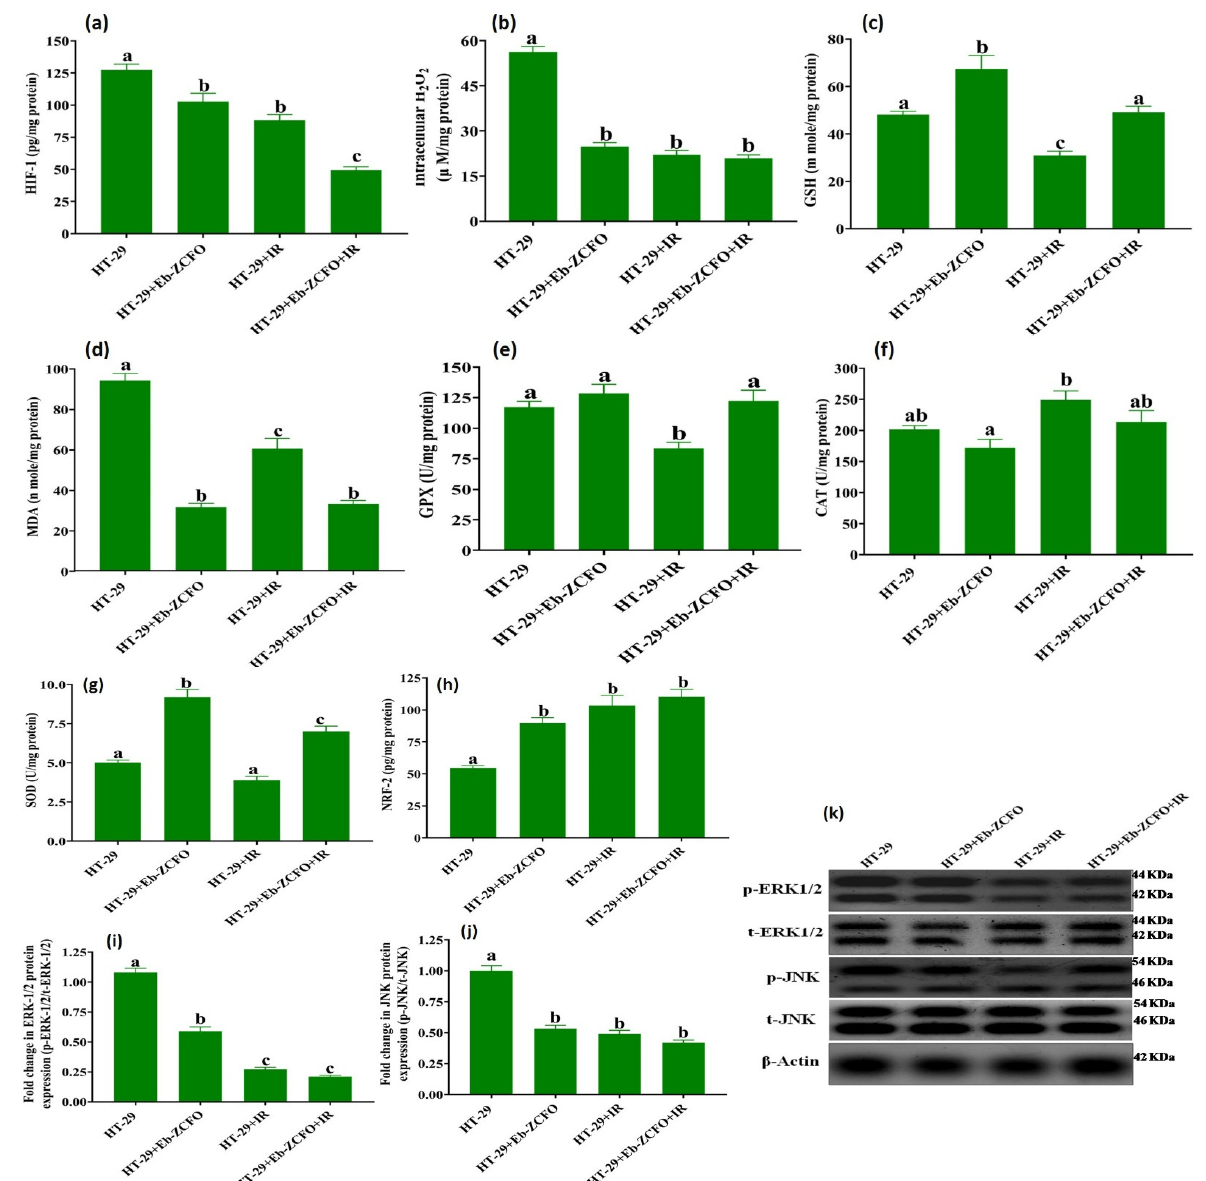
Figure 14. ROS status and associated signalling molecules ERK1/2, JNK, and NRF-2 in HT-29 cells lines. ROS status measured as follows: the levels of ( a ) HIF-1 α , ( b ) intracellular H 2 O 2 , ( c ) GSH, and ( d ) MDA; activities of ( e ) GPX, ( f ) CAT, and ( g ) SOD. ROS-sensing signalling molecules as follows: ( h ) NRF-2 level; fold change in protein expression of ( i ) ERK1/2, ( j ) JNK, and ( k ) representative western blot analysis, SDS-PAGE of ERK1/2, JNK, and β -actin. Results are expressed as the mean and standard error of the mean (SEM) (n = 3). Columns with dissimilar letters (a, b, c . . . ) overhead within the same histogram are significantly different, and columns with the same letters are not significantly different at p < 0.05. HT-29 group: untreated HT-29 cells served as control, HT-29 + Eb-ZCFO group: HT-29 cells treated with Ebselen (Eb) and ZnCe 0.06 Fe 1.94 O 4 nanoparticles (ZCFO), HT-29 + IR group: HT-29 cells exposed to γ -radiation, and HT-29 + Eb-ZCFO + IR group: HT-29 cells treated with Eb-ZCFO and exposed to